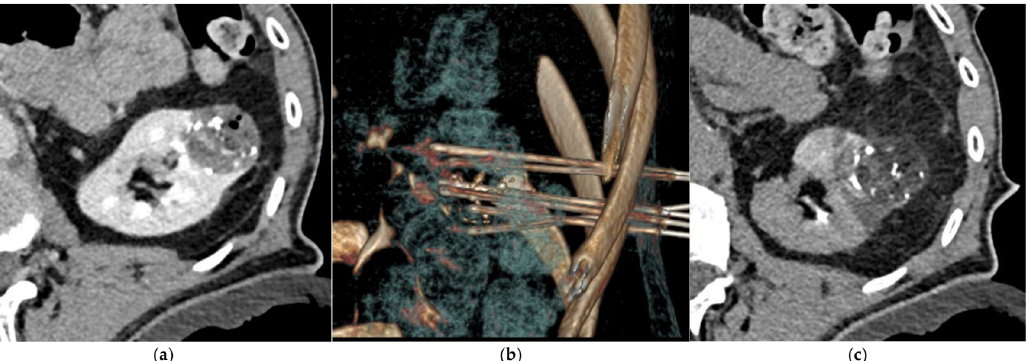
Figure 3. CT-guided percutaneous cryoablation procedure of a renal cell carcinoma of the left kidney performed after selective arterial embolization using NBCA/Lipiodol ® mixture. ( a ) Enhanced CT-scan for trajectory planification showing a complete devascularization of the tumor. Note the Lipiodol ® uptake in the tumor area that can increase targeting accuracy. ( b ) Volume rendering reconstruction showing the cryoprobes placement. ( c ) Unenhanced control CT-scan post-ablation showing the optimal coverage of the tumor without any immediate